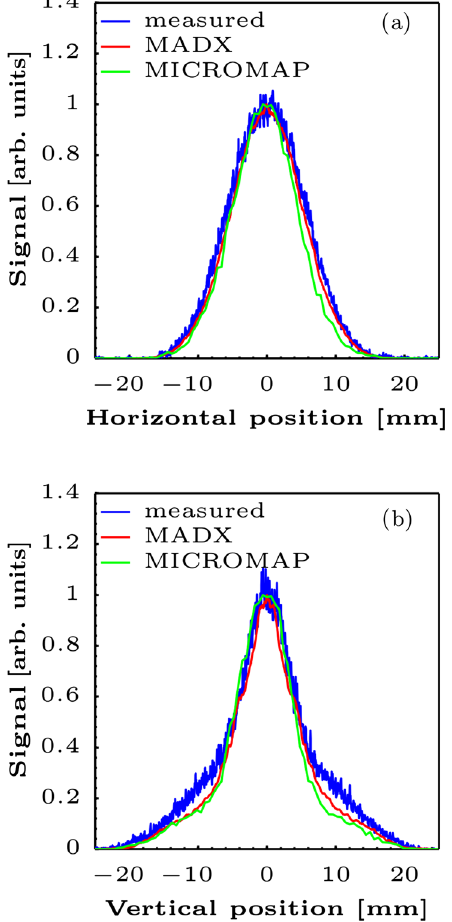
FIG. 6. Comparison between experimental and simulated final profiles for Q x 0 ¼ 6 . 104 in the (a) horizontal and (b) vertical